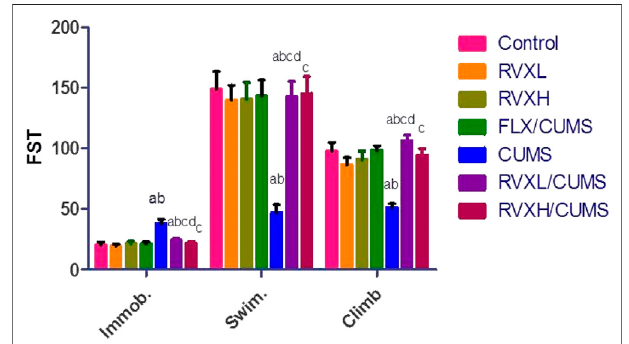
FIGURE 4 | Effect of RVX at different doses on behavior (FST). The fi ndings are displayed as mean ± S.E.M. Signi fi cant difference at p < 0.05. a Signi fi cant difference compared to the control, b signi fi cant difference compared to the FLX group, c signi fi cant difference compared to the CUMS group, and d signi fi cant difference compared to RVXH. p value < 0.0001. CUMS, chronic unpredictable mild stress; FLX, fl uoxetine; RVX L, rivaroxaban low dose; and RVX H, rivaroxaban high